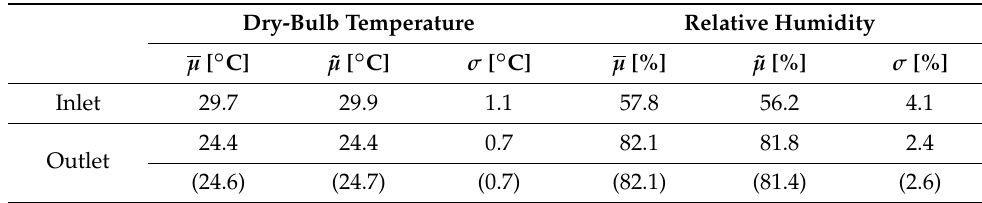
Table 2. Statistics of the psychometric properties of the air measured at inlet and outlet of the cooling pad of the compost bedded dairy barn. The statistics of the predicted outlet conditions are shown between parenthesis µ is the mean, ˜ µ is the median and σ is the standard